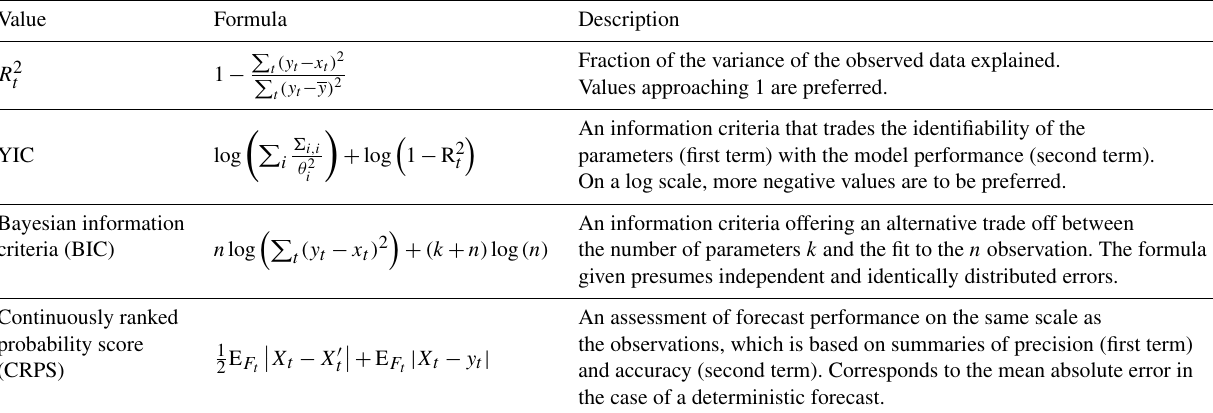
Table 1. Summaries of the model fit expressed in terms of the time-indexed observed values ( y t ), deterministic model output ( x t ) and realizations of the forecast distribution ( F t ) denoted X t and X (cid:48) t . Value Formula Description Fraction of the variance of the observed data explained. Values approaching 1 are